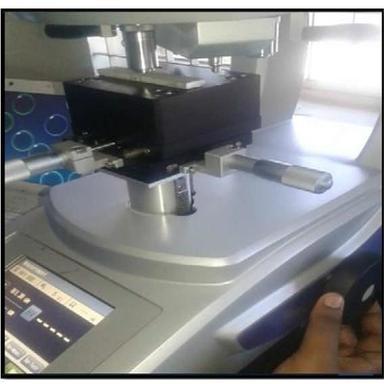
Micro Vickers Hardness.